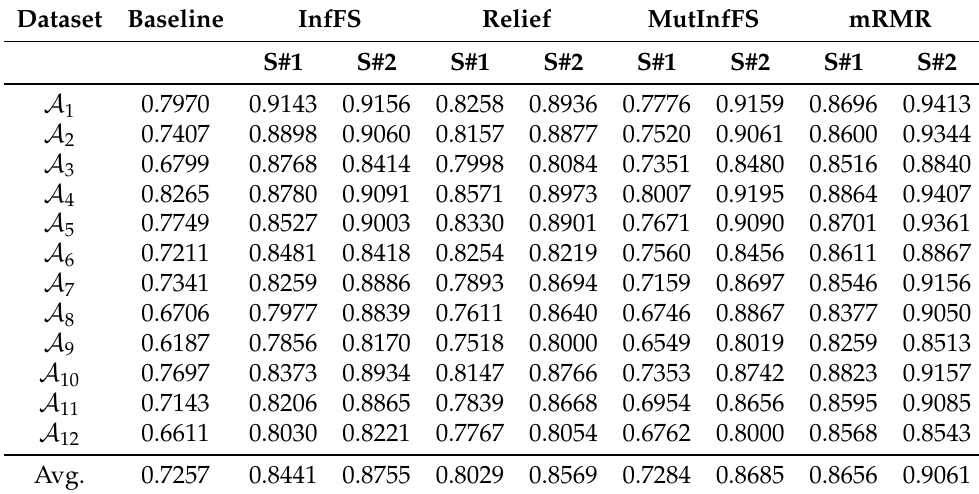
Table 2. The attained F-Measure (FM) values by means of the SVM classification model w.r.t. each